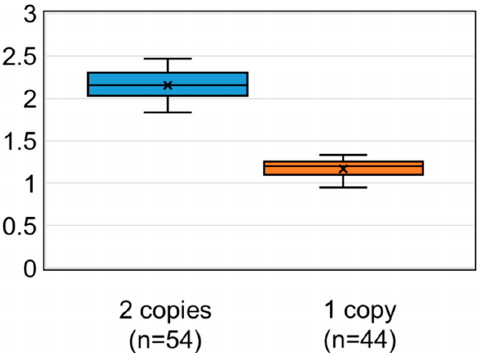
Figure 3. Calculated SMN1 copy number values using dried blood spots (DBS) on Flinders Technology Associates (FTA) cards. Box-and-whisker plots of the calculated copy number values were obtained from 54 DBS samples with two SMN1 copies and 44 DBS samples with one SMN1 copy. The x mark indicates the average value of each group.